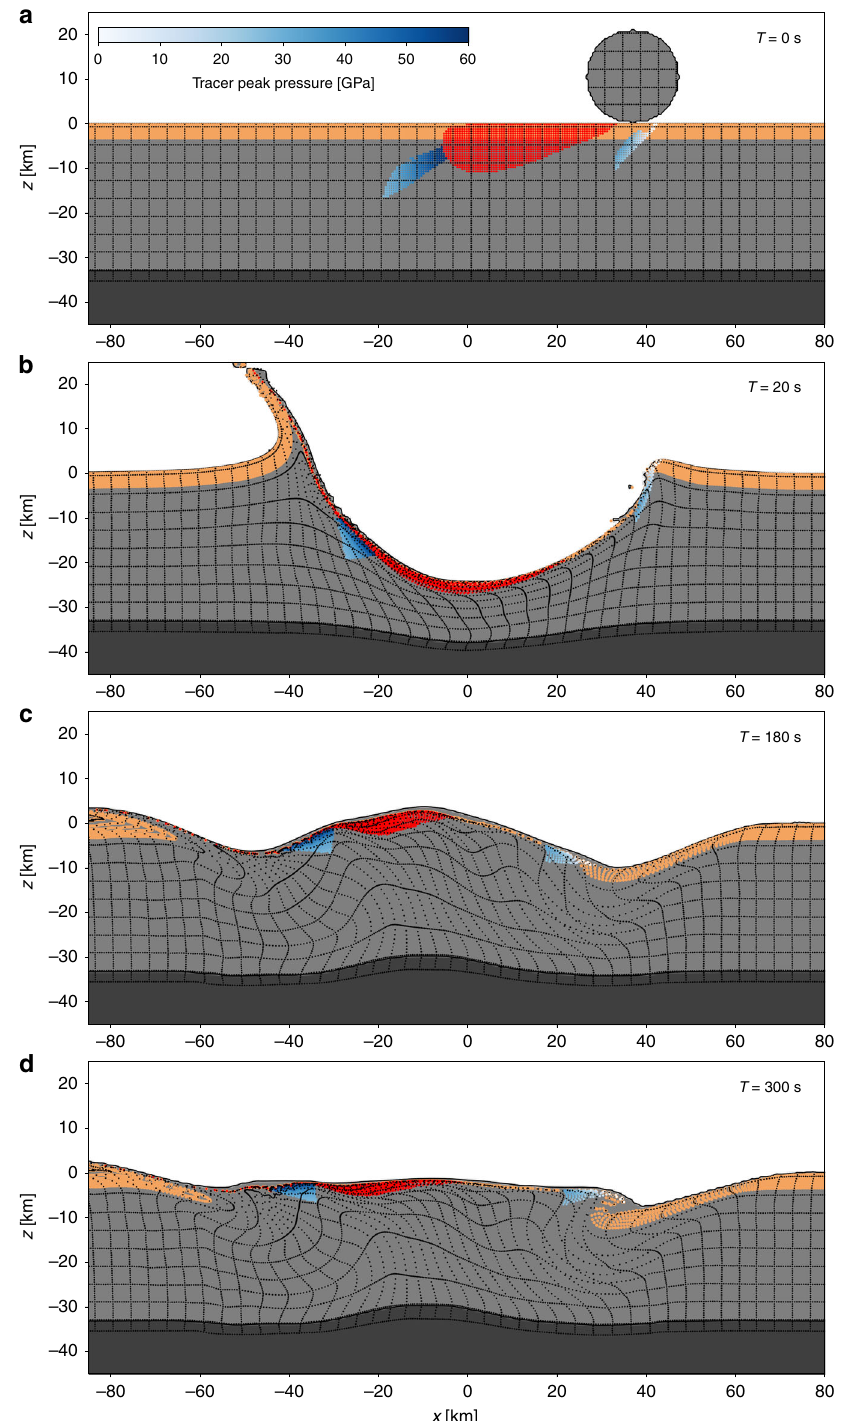
Fig. 3 Development of the Chicxulub crater for a 30 (cid:1) impact. The impact scenario depicted is for a 21-km diameter impactor with a density of 2630 kg m 3 and a speed of 12 km/s. Evolution of the crater up to 5 min after impact is depicted. Shown are cross-sections through the numerical simulation along the plane of trajectory, with x ¼ 0 de fi ned at the crater centre (measured at the pre-impact level); the direction of impact is from right to left. Colours and shading of material and tracer particles are the same as Fig.